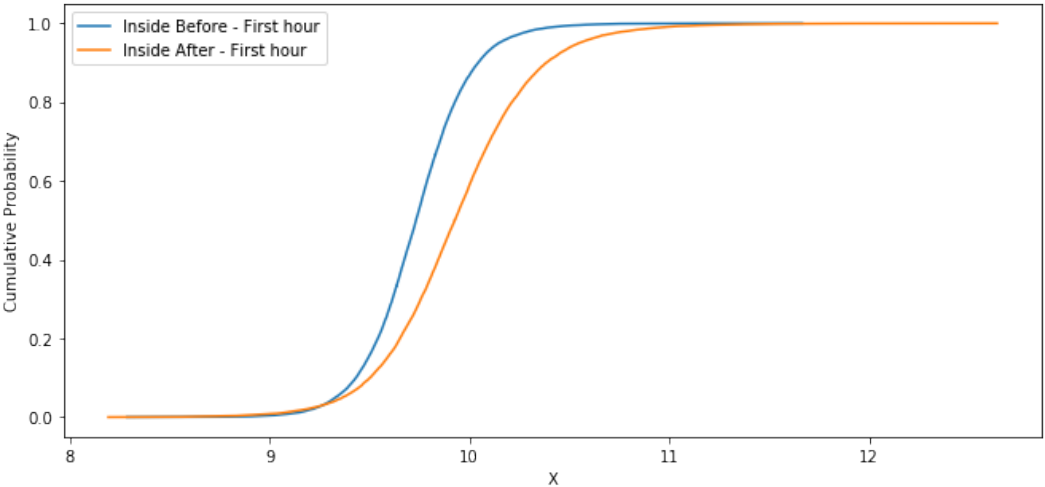
Figure 20. Cumulative Distribution Function for the inside sensor, before and after inserting the RPWs for the first